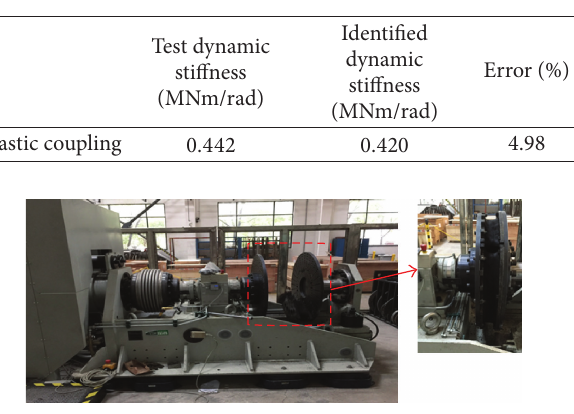
Figure 8: Elastic coupling dynamic stiffness measurement appara-